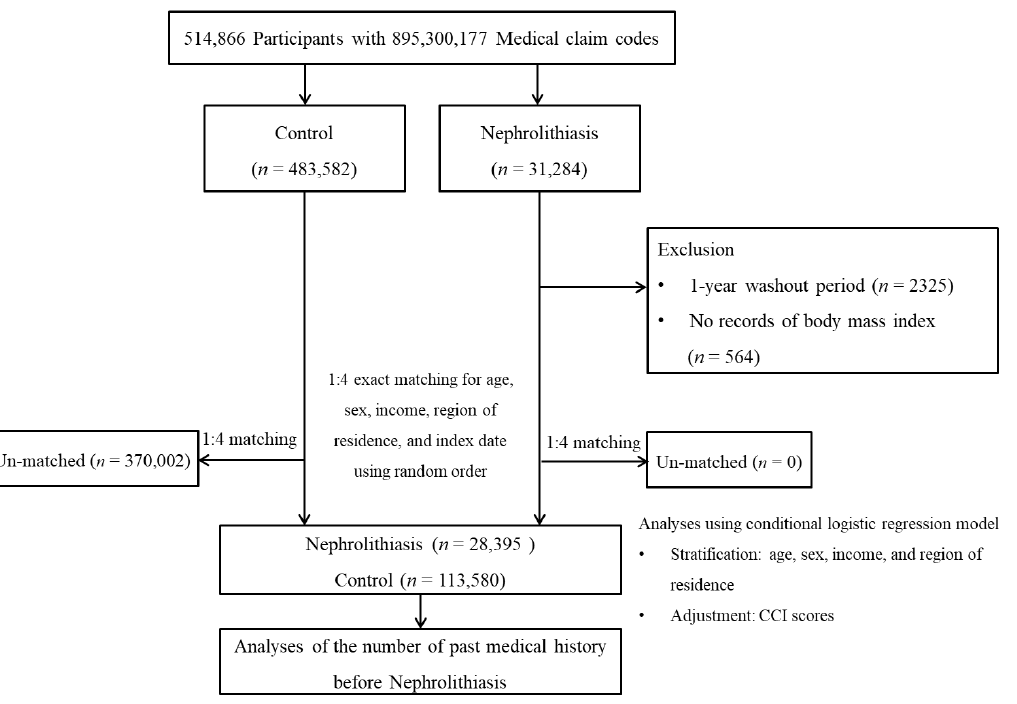
Figure 1. A schematic illustration of the participant selection process used in the present study. Of a total of 514,866 participants, 28,395 nephrolithiasis participants were 1:4 matched with 113,580 control participants for age, sex, income, and region of residence.